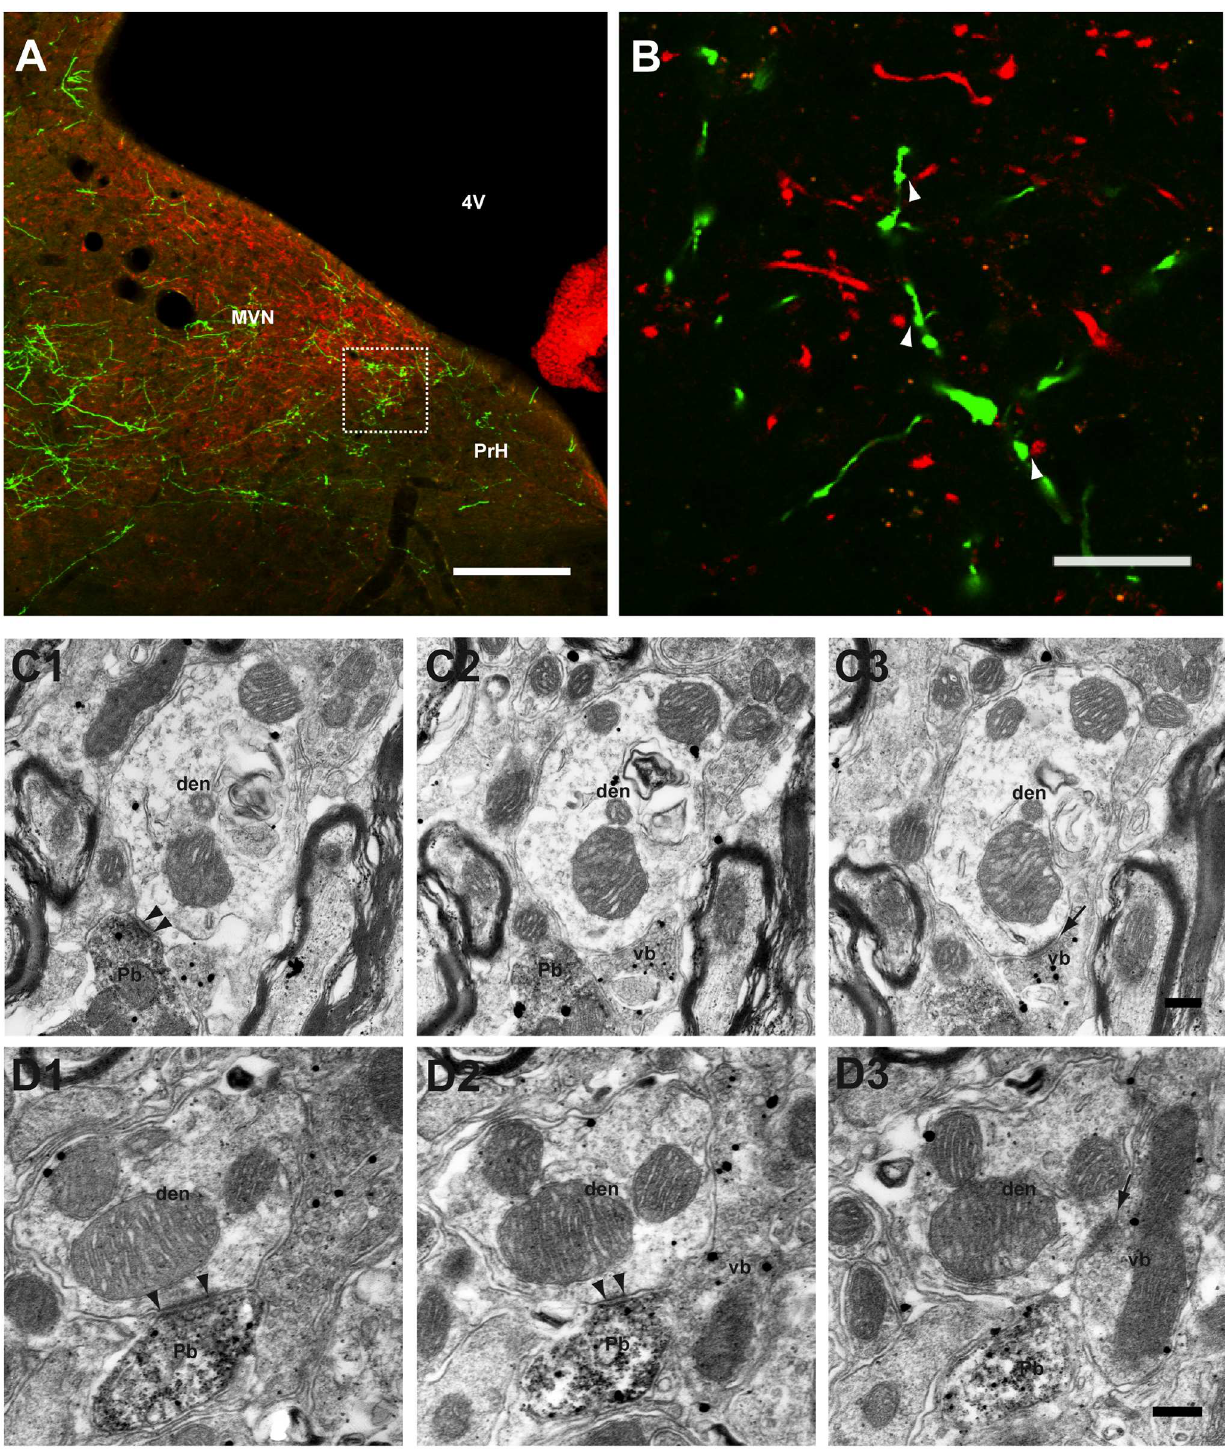
Fig 7. Distribution of vestibular nerve axonal boutons and FL P-cell axonal boutons in the parvocellular MVN/PrH. A , Low magnification image of MVN/PrH showingtwo distinct types of synaptic inputs. BDA was injected into the horizontal semicircularcanal after the lentivirusinjectioninto FL. FL P-cell axons and vestibular nerve axons were visualizedby anti-GFP antibody (green) and Alexa 594 streptavidine (red), respectively. Note that the distribution of FL P-cell axons overlappedpartially with that of the vestibular nerve axons in MVN/PrH. B , High magnification confocal image of the region marked by square in A. Some of the FL P-cell axonal boutons were closely